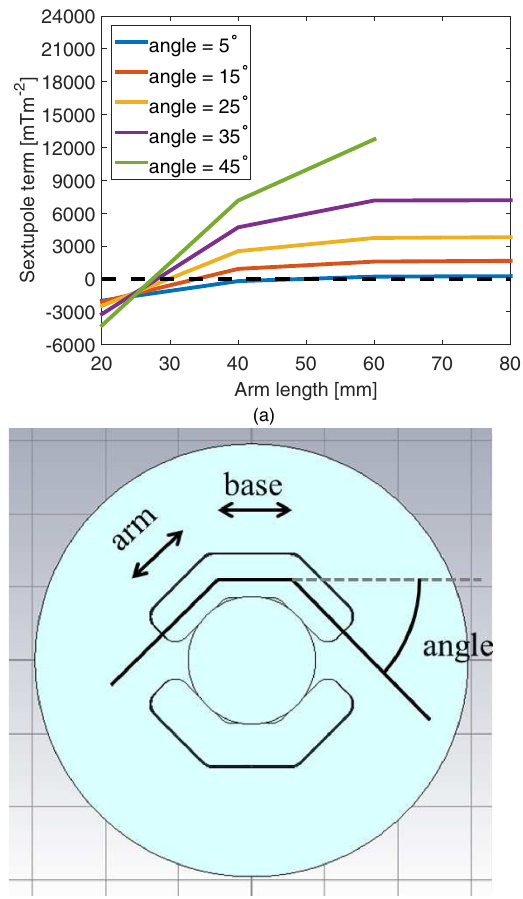
FIG. 14. (a) Sextupole component of wing shaped rods vs angle for a base width of 60 mm and (b) and the parametrization of the wing